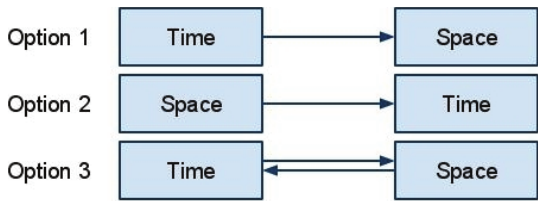
Fig. 1. Diagram of the steps in a temporal and spatial